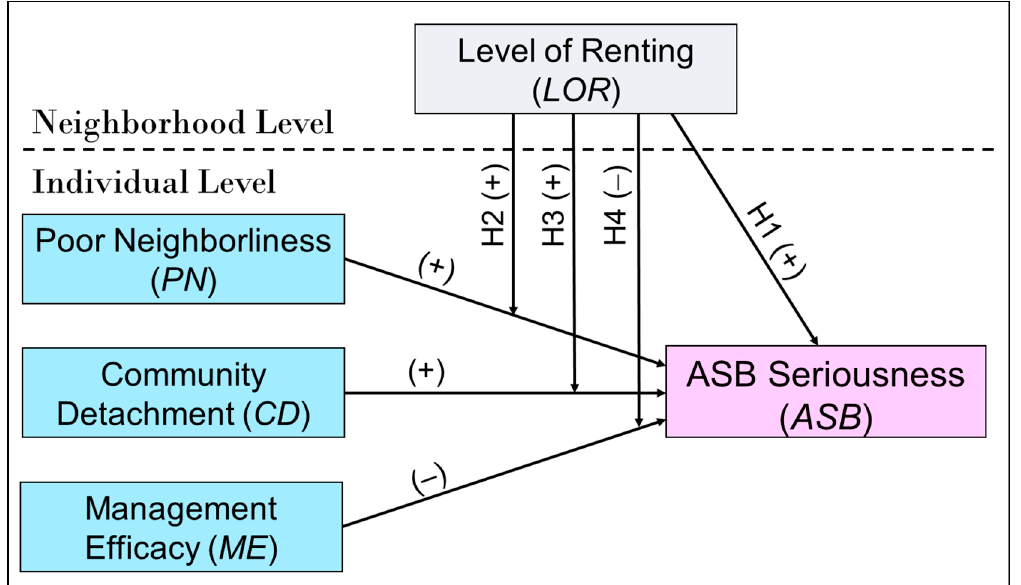
Figure 1. Conceptual framework of the research.